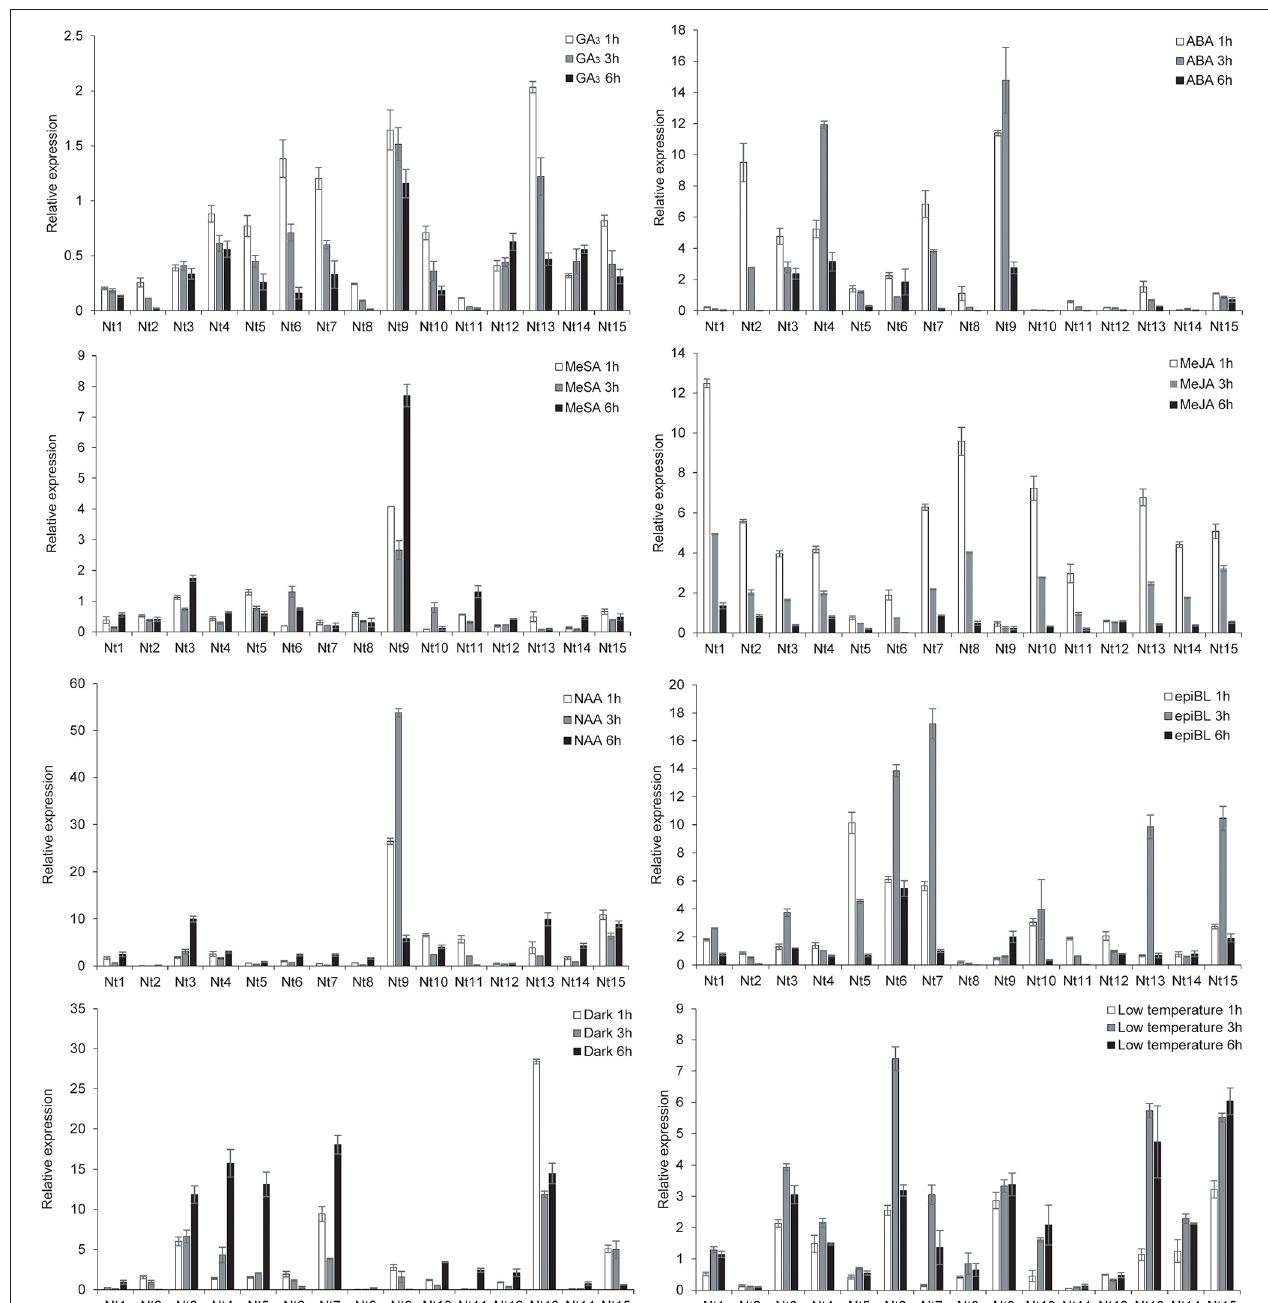
FIGURE 6 | Quantitative reverse transcription-polymerase chain reaction (qRT-PCR) analysis of NtSWN expression in response to hormone treatments and abiotic stresses. Tree-week-old seedlings were treated with 10 µ M gibberellic acid (GA3), 200 µ M abscisic acid (ABA), 2mM methyl salicylate (MeSA), 100 µ M methyl jasmonate (MeJA), 0.5 µ M α -naphthaleneacetic acid (NAA), 0.5 µ M 2,4-epi-brassionlade (epiBL), dark and 4 ◦ C. Error bars indicate SE.